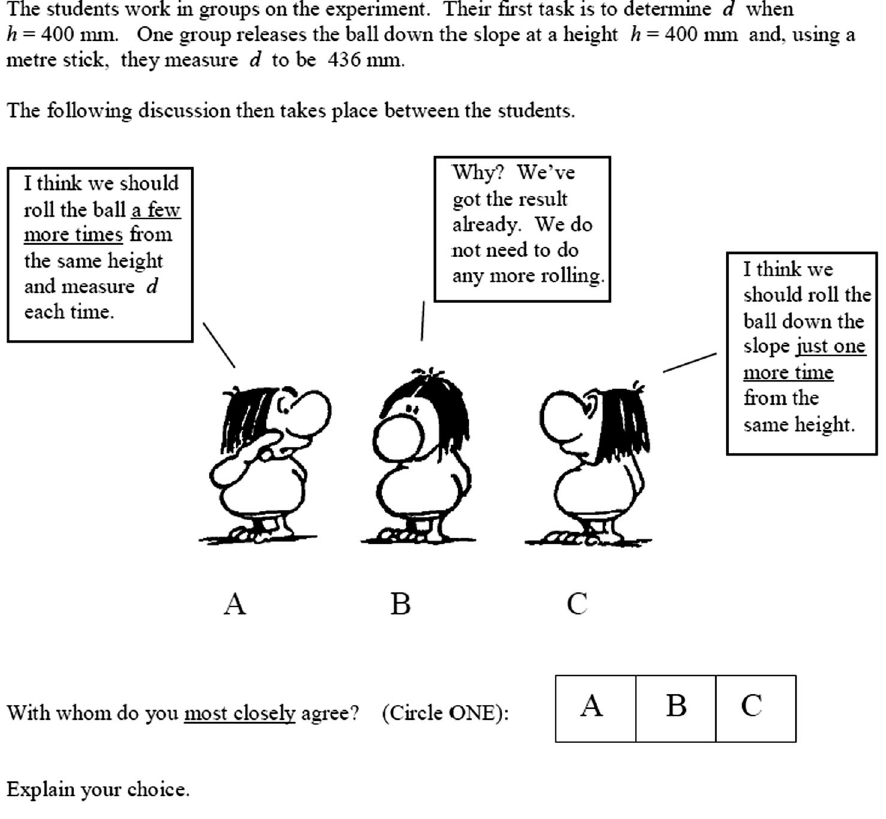
FIG. 1. The RD probe of the PMQ. Reproduced from Ref.